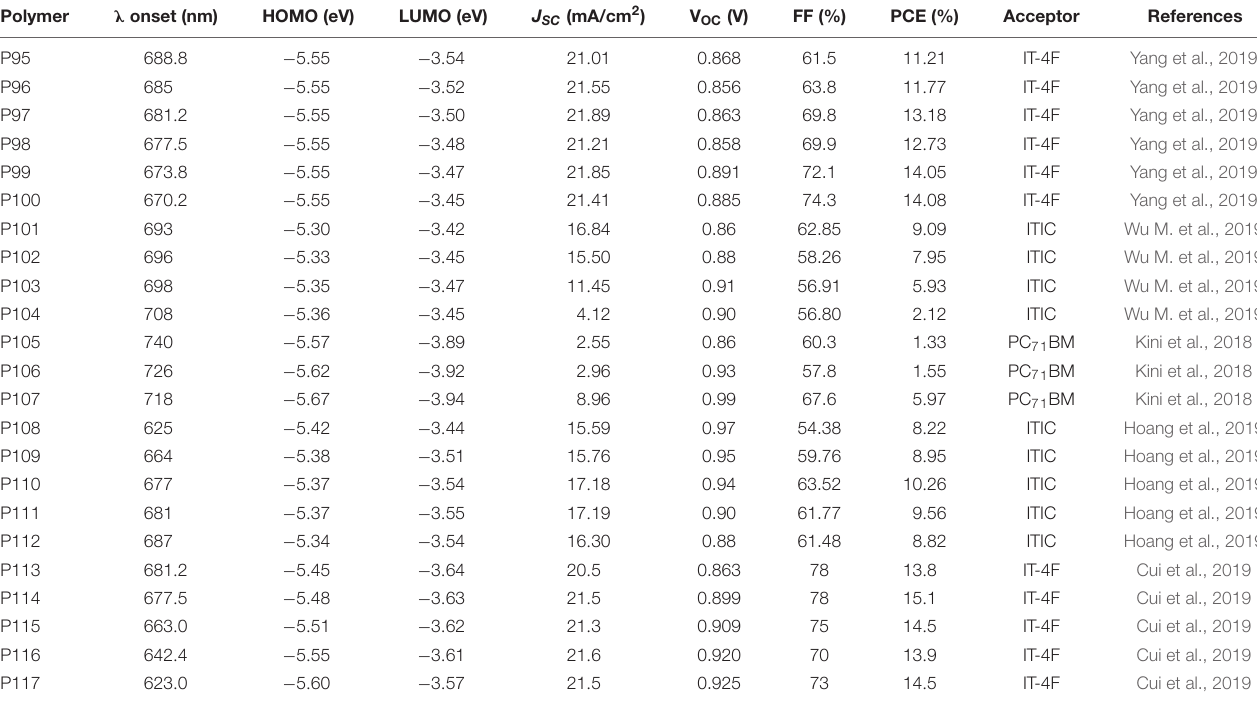
TABLE 8 | Summary of optical, electrochemical, and photovoltaic properties of polymers ( P95 – P117 ). Polymer λ onset